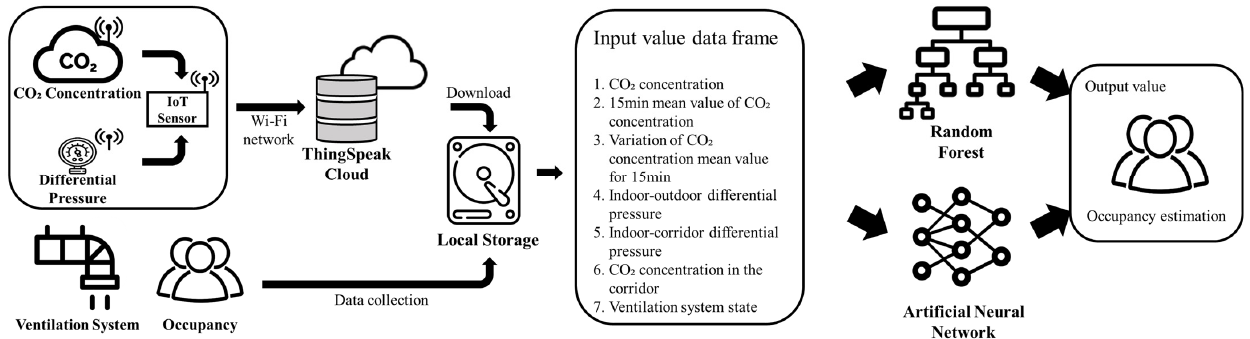
Figure 1. An overview of the process of the proposed study.